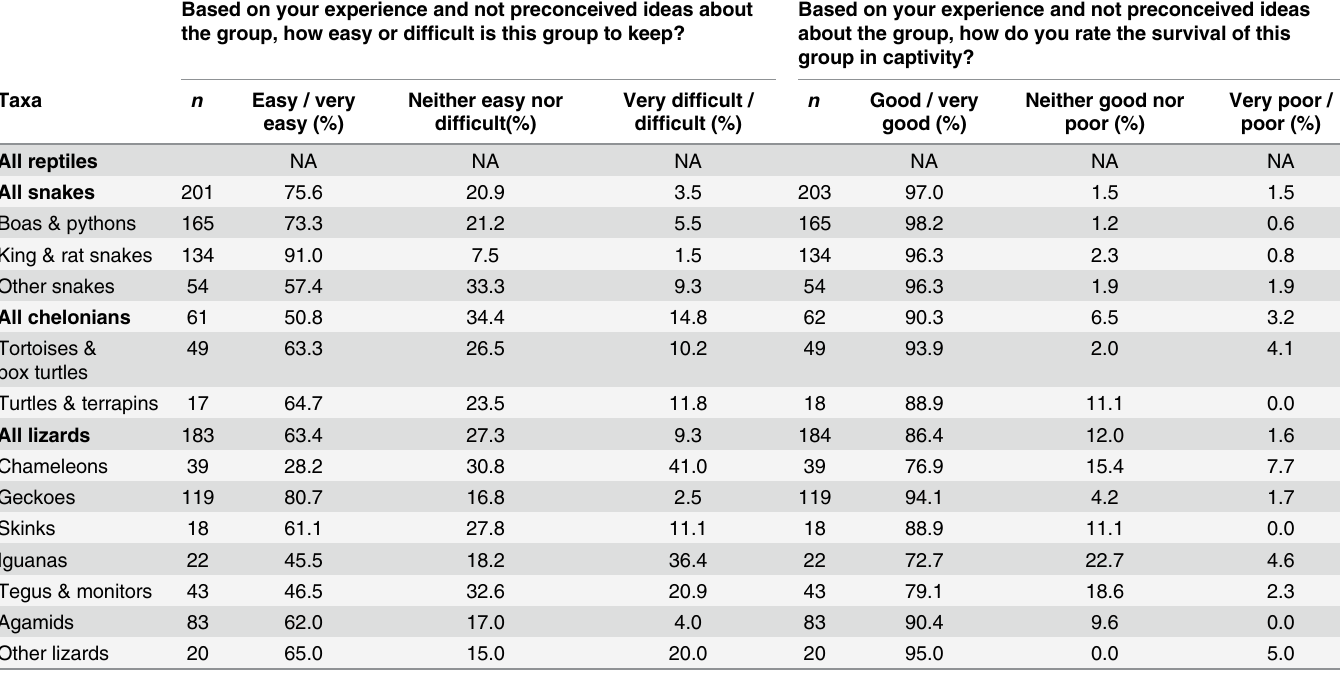
Table 3. Evaluation of respondents ’ rating of ‘ difficulty ’ and ‘ survival ’ for different reptile groups, which they had acquired. Questions were asked using a five point Likert scale, with categories condensed for data presentation. Based on your experience and not preconceived ideas about the group, how easy or dif fi cult is this group to keep?